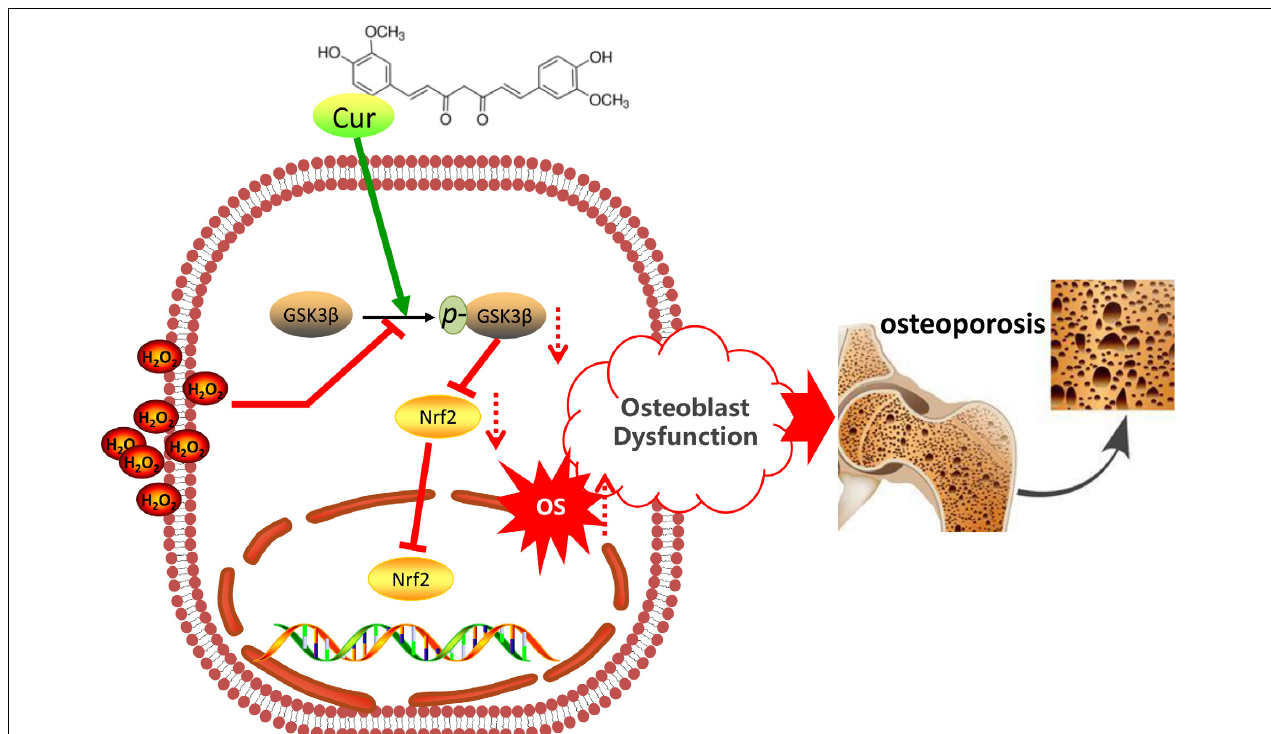
FIGURE 6 | Schematic diagram of the mechanism of Cur in OS-induced osteoblasts’ dysfunction.